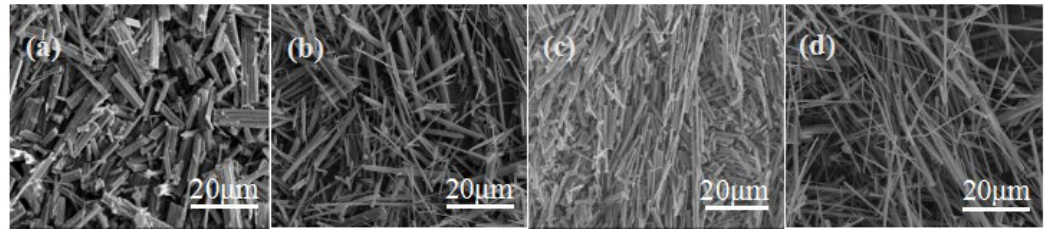
Figure 9. ESEM photos of CSHW with different aspect ratios. (The preparing parameters of ( a – d ) were shown in Table 3).